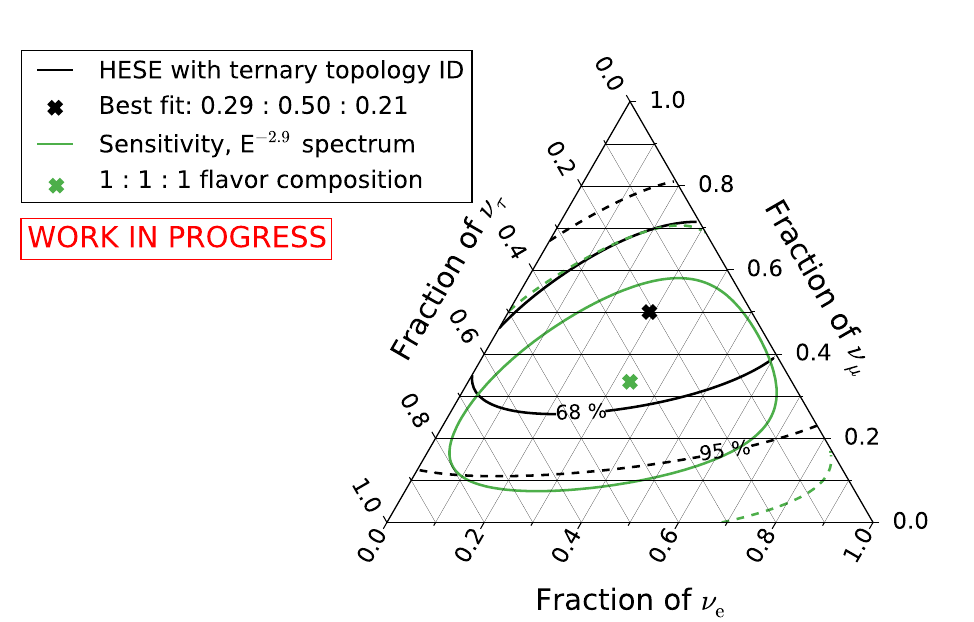
Figure 5: Measured flavor composition for 7.5 years of IceCube high-energy starting events with ternary topology ID (i.e. including the double cascade event signature) in black and expected sensitivity at the best-fit spectral index in green. Within the uncertainties, the fit result is consistent with ν : ν µ : ν τ = 1 : 1 : 1 but a zero ν τ flux e can’t be excluded either. Plot source: [ 9 ]